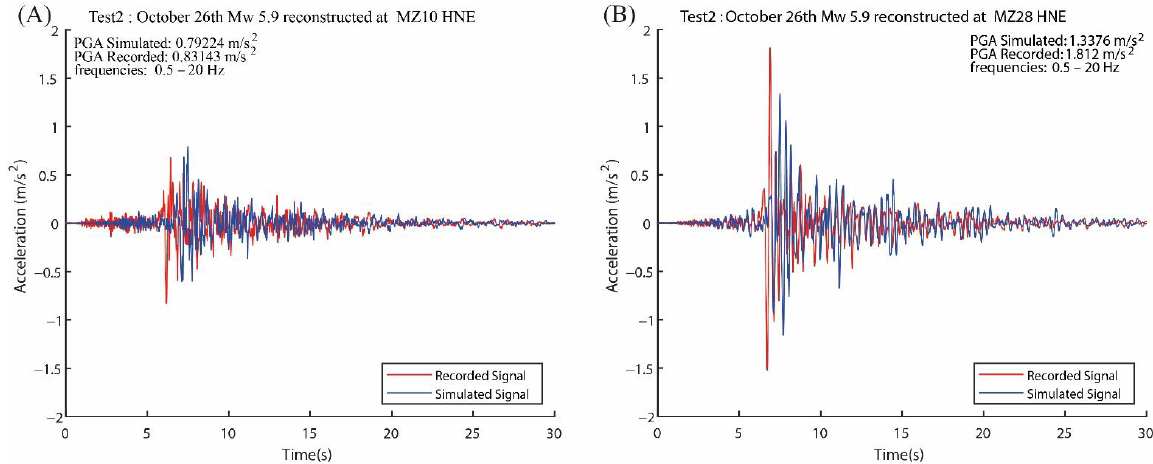
Figure 7. Comparison between recorded and simulated seismograms (EW component of acceleration) at MZ10 ( A ) and MZ28 ( B ) for Test 2. Red (blue) line represents the recorded (simulated) signal between 0.5 – 20 Hz.